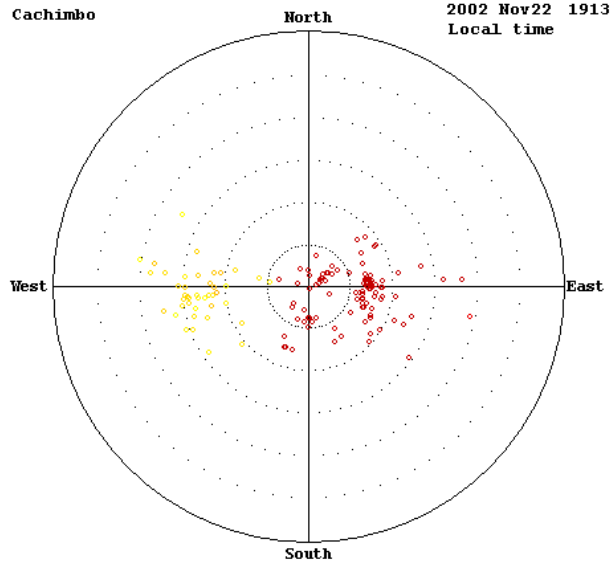
Fig. 4. Cachimbo skymap for 22 November at 19:13 LT showing echoes from the west with Doppler frequencies of − 0.5Hz, and Figure 4. Cachimbo skymap for November 22 at 1913 LT showing echoes from the west with Doppler frequencies of –0.4 Hz, and from the east with Doppler frequencies of –2.0 Hz. The from the east with Doppler frequencies of − 2.0Hz. The skymap skymap displays zenith angles from 0 to 30 ° . displays zenith angles from 0 to 20 ◦